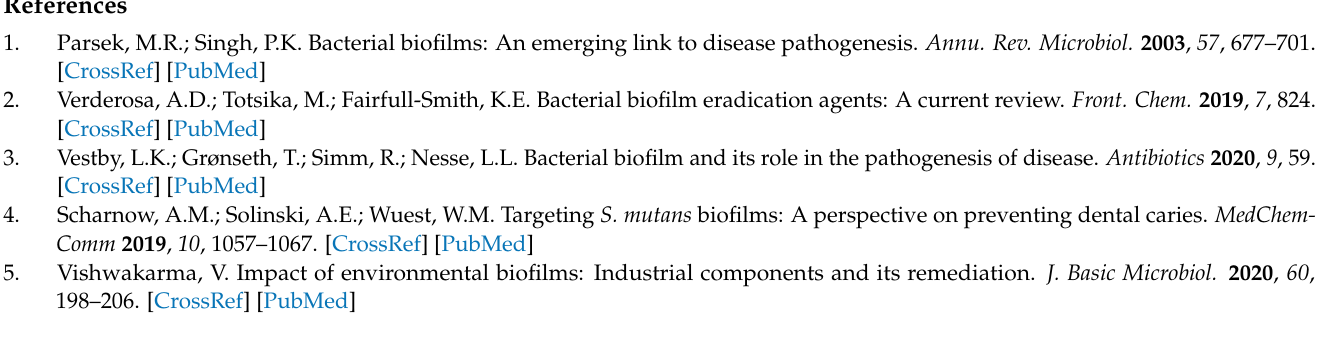
Figure S41: AFM image of 3/4S (1 × 10 − 5 M) film in the solvent system THF:CH 3 OH (100:1) after the solvent evaporation; Figure S42: Optical microscope of 3/4Sn film in the solvent system THF:CH 3 OH (100:1) after the solvent evaporation with surface disturbance; Figure S43: Optical microscope of 3/4Sn film after 120 min during the H 2 O 2 surface treatment after 120 min; Figure S44: EPR spectra of 3n sample at room temperature in stationary (a) and in pulsed (b) modes of the X-band (9.6 GHz); Figure S45: EPR spectra of 3/4Sn film and 3/3Sn film at room temperature before irradiation with an X-ray